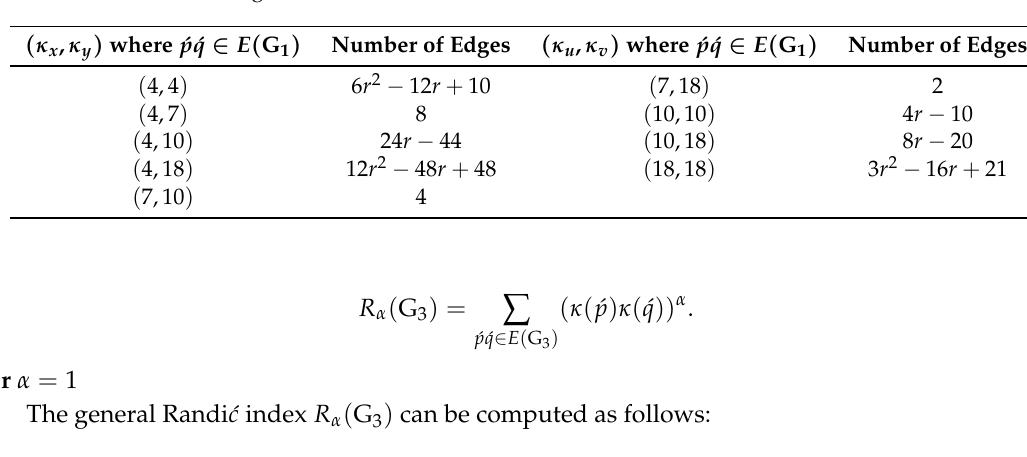
Table 3. Edge partition of rectangular hex-derived network of type 3, RHDN 3 ( r ) based on degrees of end vertices of each